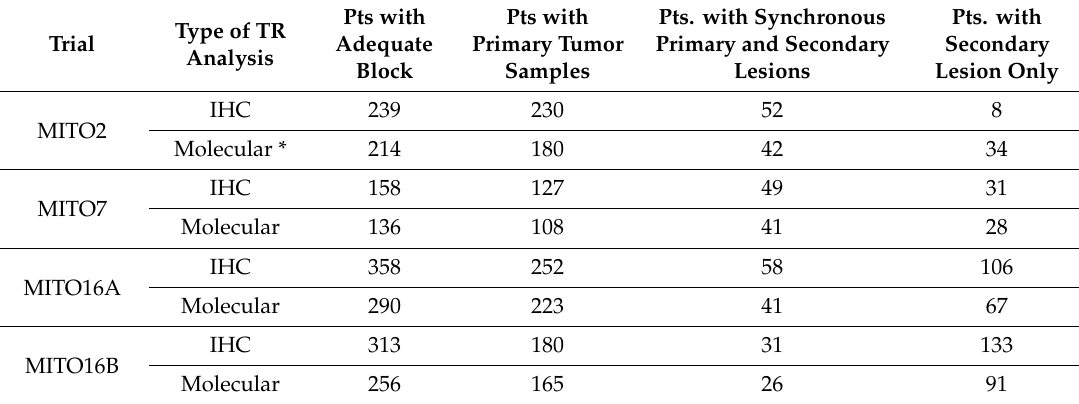
Table 3. Synchronous primary tumor and secondary peritoneal samples.